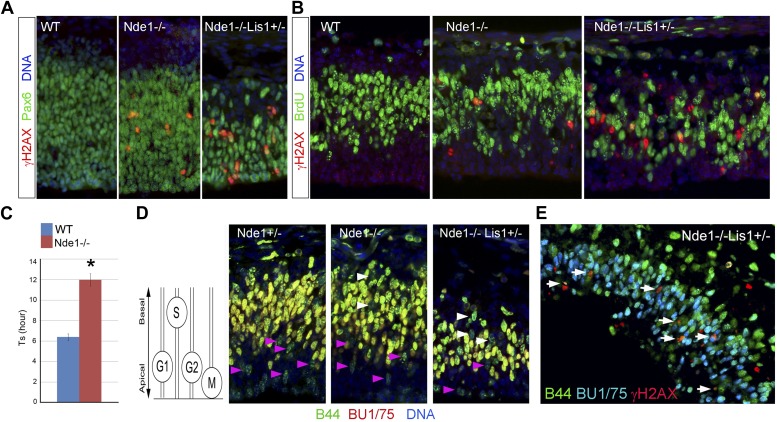
DNA damage caused by Nde1 mutation occurs concurrently with DNA replication.(A) Co-immunostaining of γH2AX (red) and multipotent/primary progenitor marker Pax6 (green) on cortical sections at E12.5. (B) Co-immunostaining of γH2AX (red) and BrdU (green); cortical sections were prepared from BrdU pulse (30 min) labeled embryos at E12.5. Quantification of γH2AX+ cells showed that 18.3 ± 6.1% (mean ± SD) of γH2AX+ Nde1−/− and 23.4 ± 3.1% (mean ± SD) of γH2AX+ Nde1−/−Lis1+/− cells were also BrdU+. (C) S phase duration (Ts, hr) measurement indicates significant delay of DNA replication in Nde1−/− neural progenitors. Data are mean ± SD, p < 0.0001 by Student's t test. (D) Representative images of B44 (green, recognizes both IdU and BrdU) and BU1/75 (red, recognizes only BrdU) double immunohistological staining in an IdU (2 hr), BrdU (30 min) sequential labeling experiment. Cells that have finished S phase and progressed to G2/M are indicated by pink arrows; cells that remained in the S phase zone but stopped incorporating BrdU are indicated by white arrows. A diagram to indicate the cell cycle dependent nuclei position through INM is included. (E) B44 (green), BU1/75 (blue), and γH2AX (red) triple immunostaining of cortical sections of Nde1−/−Lis1+/− mutant after IdU (2.5 hr), BrdU (30 min) sequential labeling. 47.5 ± 0.1% (mean ± SD) of total γH2AX+ cells were B44+BU1/75−, indicating the association of DNA damage with stalled DNA replication (white arrows).